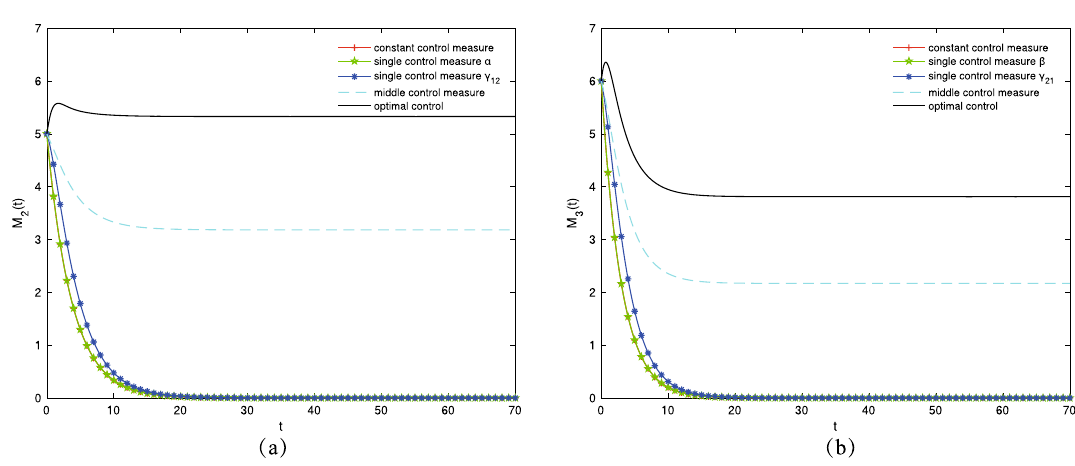
Figure 5. The densities of ( a ) M 2 ( t ) , ( b ) M 3 ( t ) change over time under different control